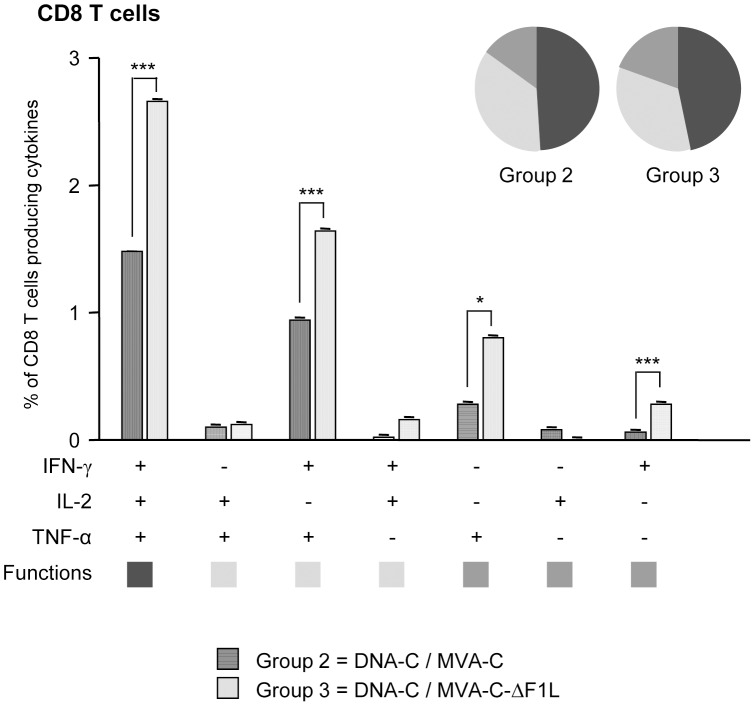
Functional profile of the adaptive HIV-1-specific CD8 T cell response in the different immunization groups.All the possible combinations of the responses are shown on the x axis, whereas the percentages of the functionally distinct cell populations within the total CD8 T cell population are shown on the y axis. Responses are grouped and color-coded on the basis of the number of functions. The non-specific responses obtained in the control group DNA-φ/MVA wt were subtracted in all populations. * p<0.05; *** p<0.001. p values indicate significantly higher responses compared to DNA-C/MVA-C immunization group.